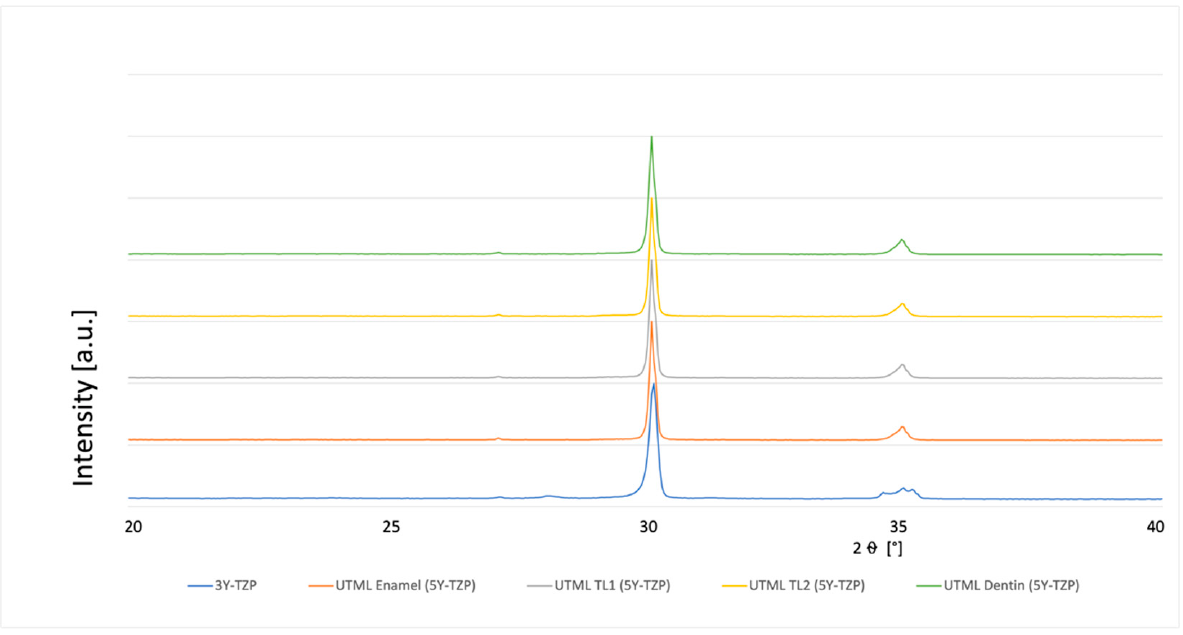
Figure 5. XRD analysis 3Y-TZP and 5Y-PSZ 600 Grit and fully sintered before cutting.